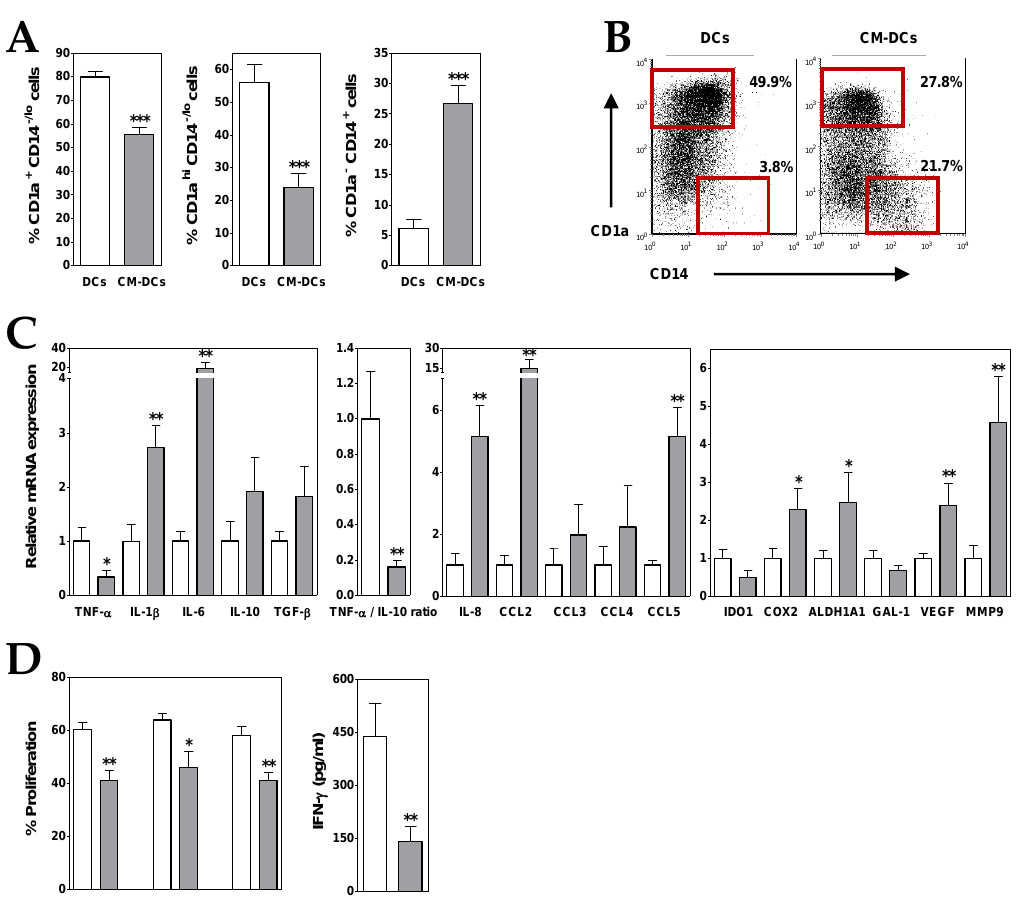
Figure 1. ALL cells alter the di ff erentiation of dendritic cells (DCs). ( A ) Percentages of CD1a + CD14 − / lo , CD1a hi CD14 − / lo and CD1a − CD14 + cells recovered after 5–6 days of culture in the absence (white bars; DCs) or presence (grey bars; CM-DCs) of conditioned media from ALL cells. Data represent the mean ± SEM of 12 to 15 independent experiments. ( B ) Representative dot plots showing CD14 versus CD1a expression. Percentages of CD1a hi CD14 − / lo and CD1a − CD14 + cell populations, delimited by red gates, are shown. ( C ) Real-time PCR quantification of mRNA levels in DCs di ff erentiated from monocytes in the absence (white bars) or presence (grey bars) of conditioned media from ALL cells. Relative mRNA expression was calculated by dividing all individual data by the mean expression in control DCs. Results represent the mean ± SEM of five to seven independent experiments. ( D ) Histograms show the percentages of proliferating CD4 + and CD8 + T cells, gated on the CD3 + cell population and calculated by the CFSE dilution method in mixed lymphocyte reaction assays. Data are the mean ± SEM of seven independent experiments. Supernatants from DC / T cell co-cultures were harvested at day 5-6 and the amount of IFN- γ was quantified by ELISA. Data are the mean ± SEM of three to six independent experiments. Asterisks represent statistically significant di ff erences between DCs and CM-DCs (* p ≤ 0.05, ** p ≤ 0.01 and *** p ≤ 0.001; by Mann–Whitney test).